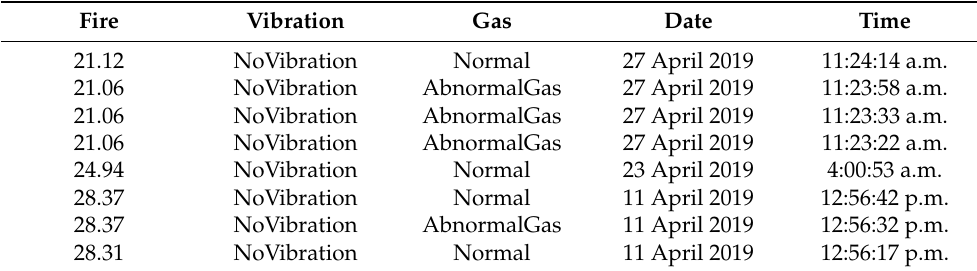
Table 4. Time efficiency of the gas sensor in transmitter